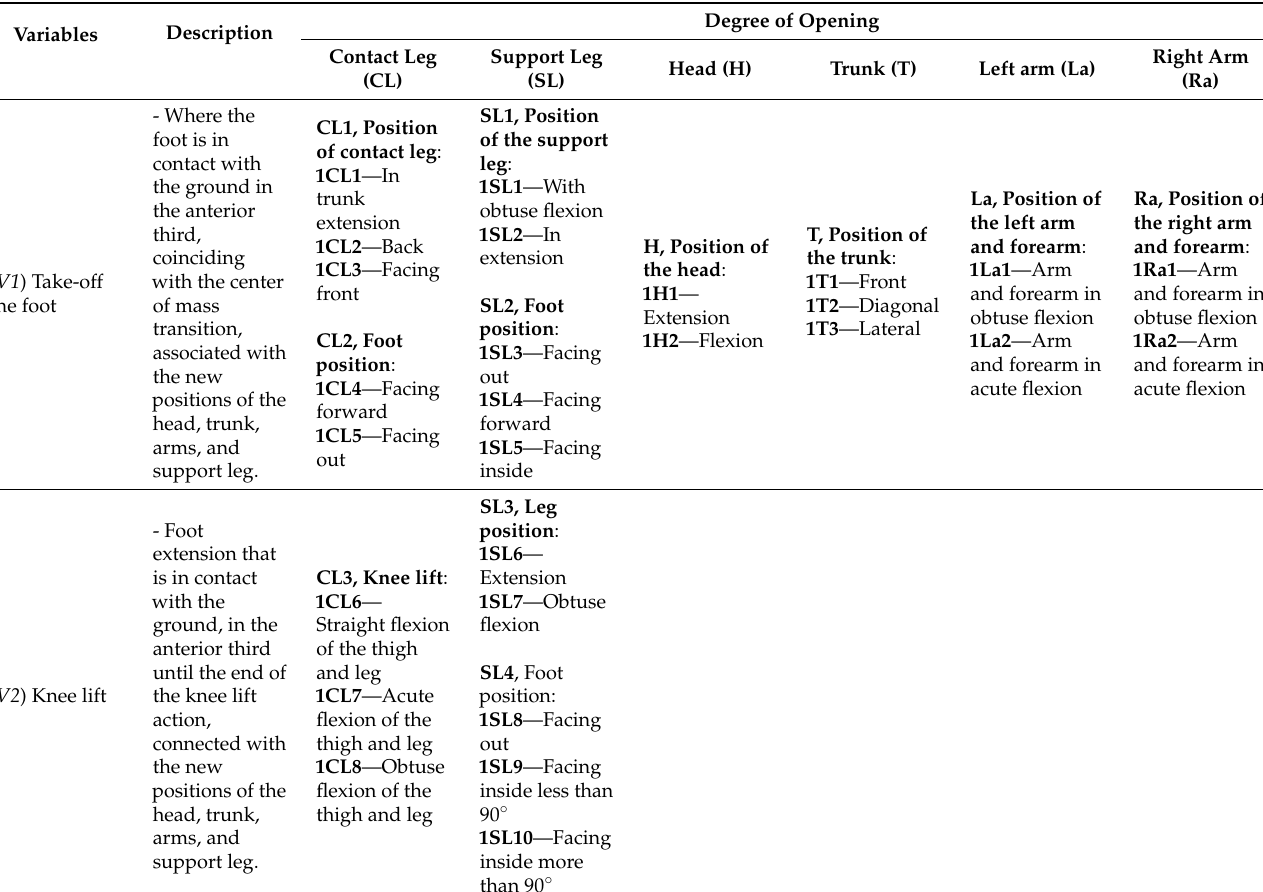
Table 3. Contextual data (dimensions), degree of opening and description of key